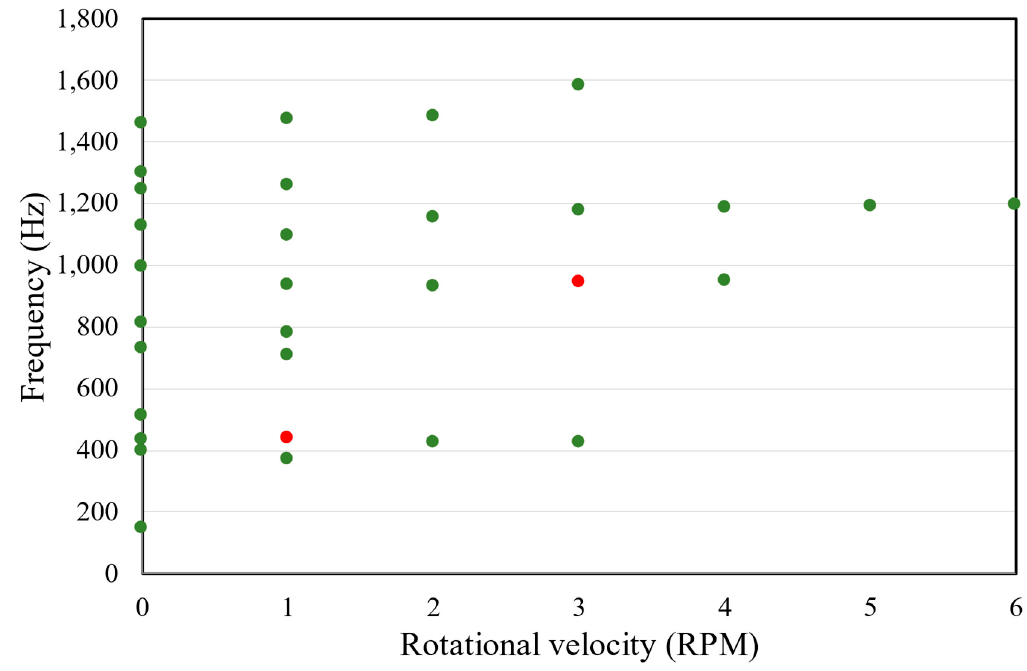
Figure 28. The SAFE diagram of two-stage moving blade